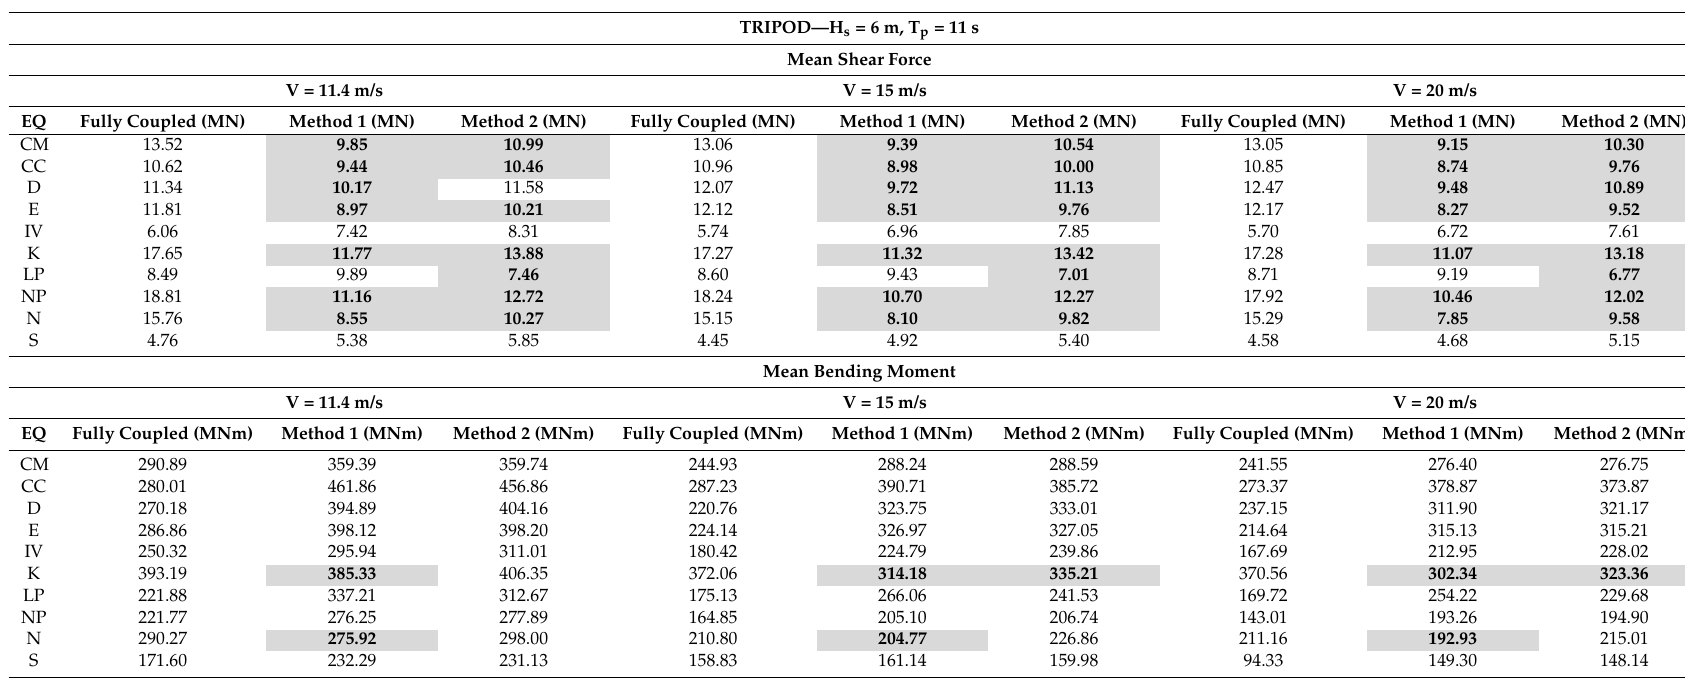
Table 7. Tripod: Mean shear-force and bending-moment demands at tower base, obtained by Methods 1-2 for sea state parameters H s = 6 m, T p = 11 s, all wind velocities and earthquake records listed in Table